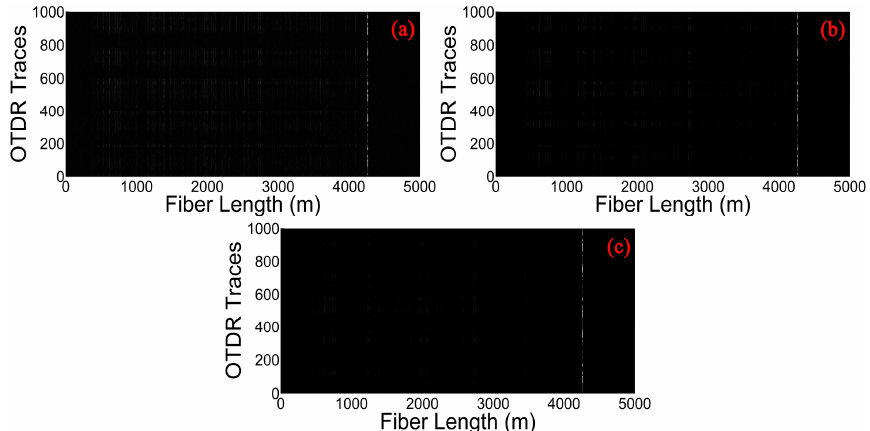
Figure 3. Gray image obtained by different methods. ( a ) Moving differential method; ( b ) Curvelet denoising method based on the traditional thresholding; ( c ) Curvelet denoising method based on the optimized thresholding.